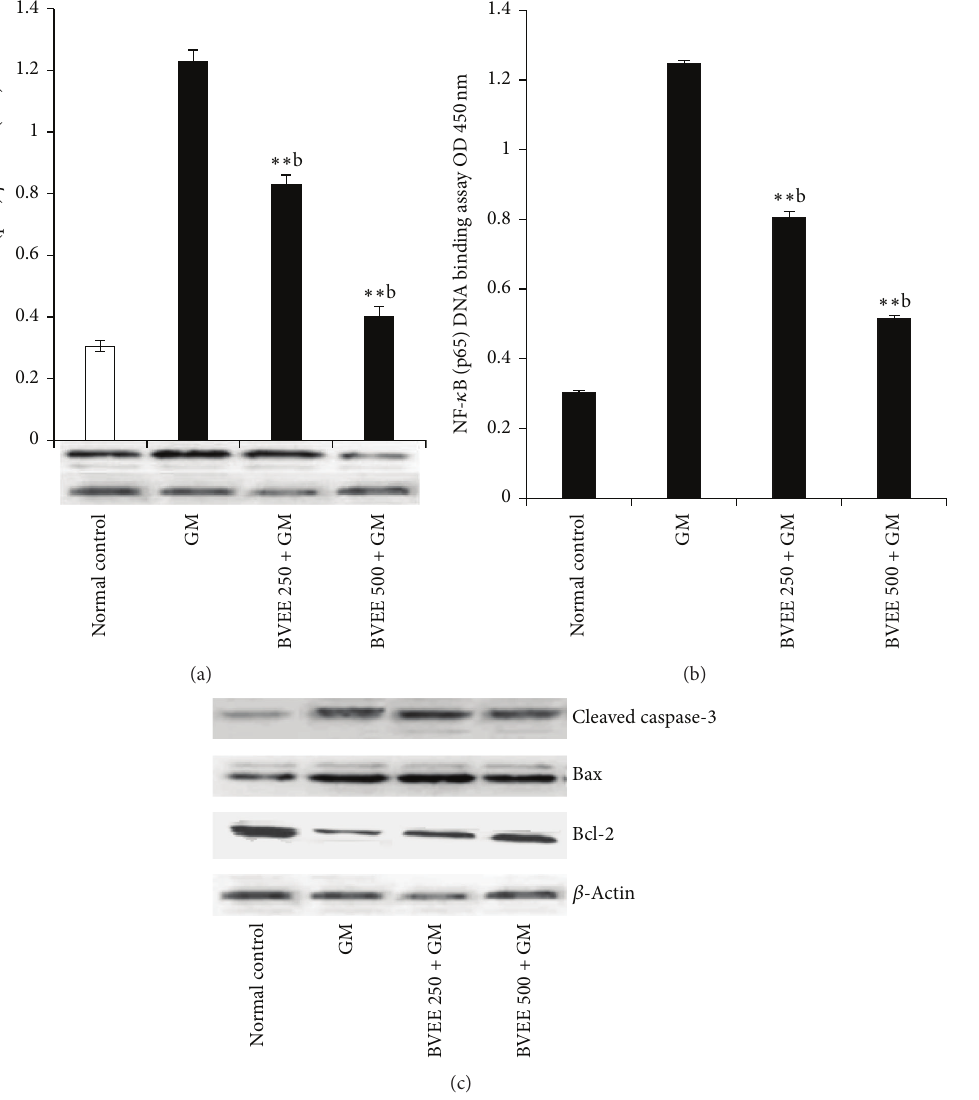
Figure 4: Effect of BVEE on gentamicin-induced changes in inflammatory and apoptotic markers in kidney tissues of rats. (a) Immunoblots analysis of nuclear NF- 𝜅 B (p65) expression in the kidney tissue of rats treated with BVEE and/or gentamicin. Β -Actin expression was used as a loading control. Representative bar diagram showing quantitative relative levels of NF- 𝜅 B (p65) protein for vehicle, GM, and GM and BVEE treated rats. (b) Nuclear NF- 𝜅 B (p65) DNA-binding activity determined by using NF- 𝜅 B (p65) transcription factor ELISA assay kit. (c) Immunoblot analysis of apoptotic marker cleaved caspase-3 and Bax protein and antiapoptotic marker Bcl-2 protein in comparison with Β -actin expression was used as a loading control. The results are presented as the mean ± SEM of six animals per group. “ ∗ , ∗∗ ” ∗∗∗ denotes significant differences from the control group ( 𝑃 < 0.05 , 𝑃 < 0.01 , and 𝑃 < 0.001 ); “ a , b , c ” denote significant differences from the GM group ( 𝑃 < 0.05 , 𝑃 < 0.01 , and 𝑃 < 0.001